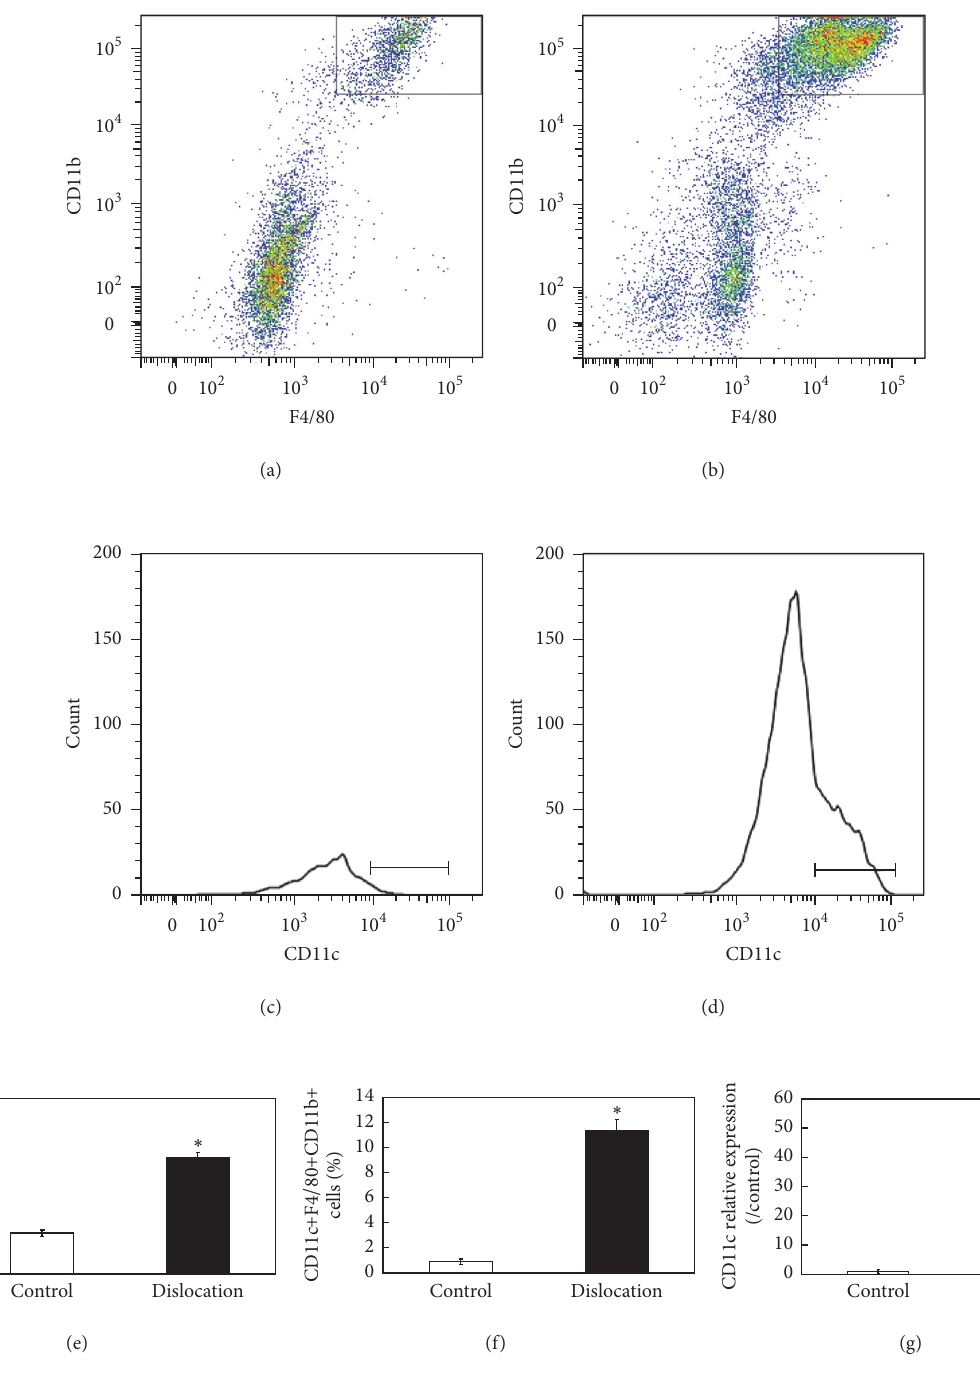
Figure1:CharacterizationofmacrophagecellsininflamedsynovialtissueofC57BL/6Jmice.FlowcytometricanalysisofCD11c + F4/80 + CD11b macrophage cells in the synovial tissue (ST) obtained from the control and dislocated side of a patellar surgical dislocation model generated in C57BL/6J mice (a–f). (a, b) Dot-plot analysis of F4/80 + CD11b + cells in ST of the control (a) and dislocated side (b) of mice; 𝑥 -axis, F4/80; 𝑦 -axis, CD11b. (c, d) Histogram analysis of CD11c + cells in the gated regions in the dot-plots of ST cells isolated from the control (c) and dislocated side (d) of mice. Percentages of F4/80 − and CD11b + cells (e) and CD11c + cells in the F4/80 − and CD11b-positive gated regions in the ST of control and dislocated side (f) of mice ( 𝑛 = 5 ). (g) Real-time PCR analysis of CD11c expression in the ST obtained from the control and dislocated side of C57BL/6J mice ( 𝑛 = 5 ). ∗ Statistically significant difference between the control and dislocated side. All data are presented as the mean ± standard error ( 𝑛 = 5